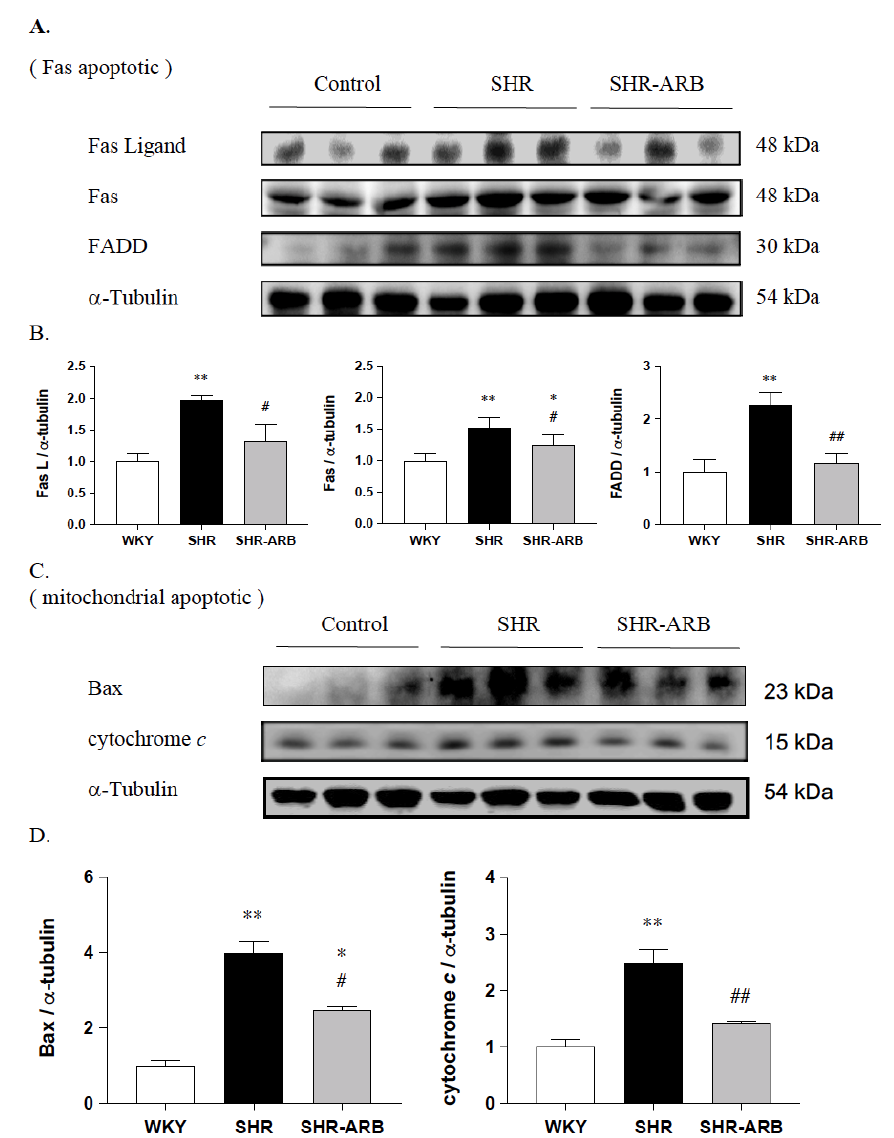
Figure 2. ( A ) The representative protein levels of Fas ligand, Fas receptor (Fas), and Fas-associated death domain (FADD). The α -Tubulin served as an internal control. ( B ) Bars indicate the relative fold changes of protein levels relative to the Control group in Fas ligand, Fas, and FADD on α -Tubulin and mean ± standard deviation (n = 8;8;8). ( C ) The representative protein levels of pro-apoptotic Bax and cytosolic cytochrome c from the left ventricles in the normotensive group (WKY), untreated hypertensive group (SHR), and SHR rats with treated irbesartan (SHR-ARB), as measured by Western blot methods. The α -Tubulin served as an internal control. ( D ) Bars indicate the relative fold changes of protein levels relative to the Control group in Bax and cytosolic cytochrome c on α -Tubulin and show mean ± standard deviation (n = 8;8;8). * p < 0.05, ** p < 0.01: significant differences from the Control group. # p < 0.05, ## p < 0.01 indicates significant differences between the SHR group and the SHR-ARB group.